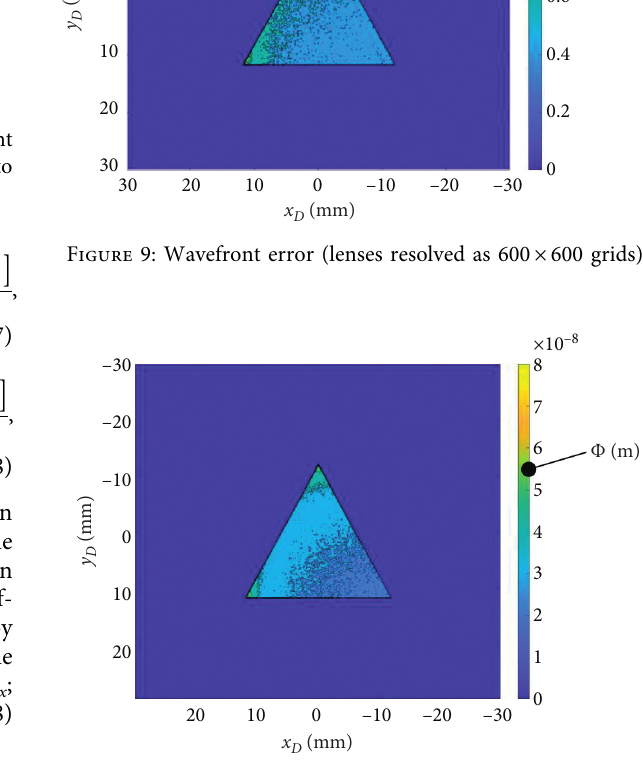
Figure 10: Wavefront error for increased resolution (lenses re- solved as 1000 × 1000